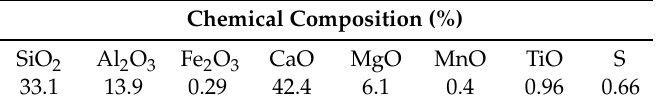
Table 2. Chemical composition of blast furnace slag.